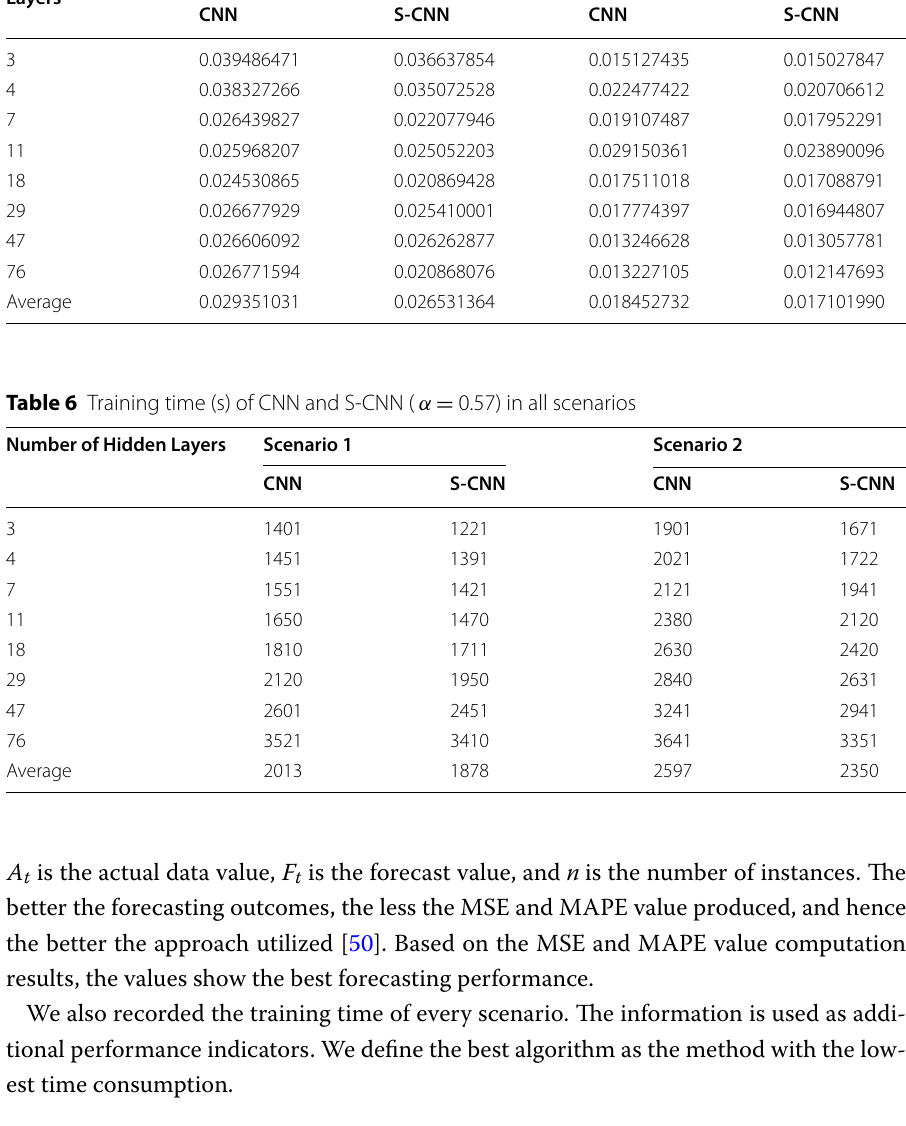
Table 5 MSE of CNN and S-CNN ( α Number of Hidden Layers